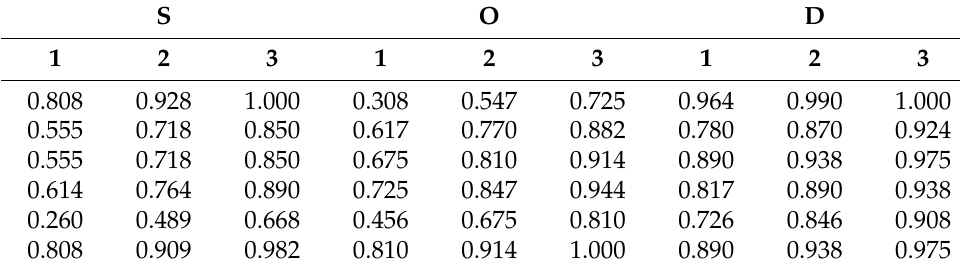
Table 11. WPM decision matrix.